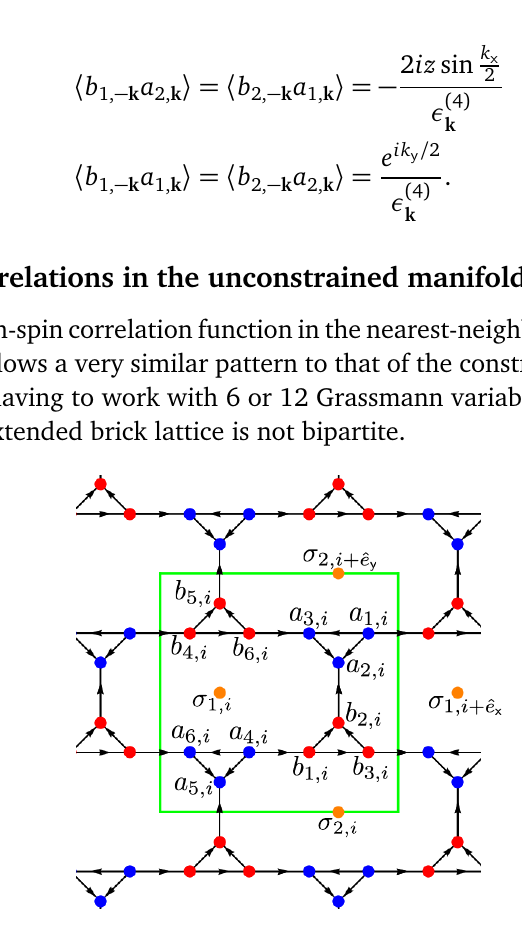
Figure 33: Extended brick lattice used for calculation of the nearest-neighbour TLIAF spin-spin correlation function in the unconstrained manifold. The (non-minimal) unit cell contains two spins, σ and σ , as well as twelve Grassmann variables, labelled a 1, i 2, i spins can be determined by studying expectation values of pairs of Grassmann variables associated with the intermediate